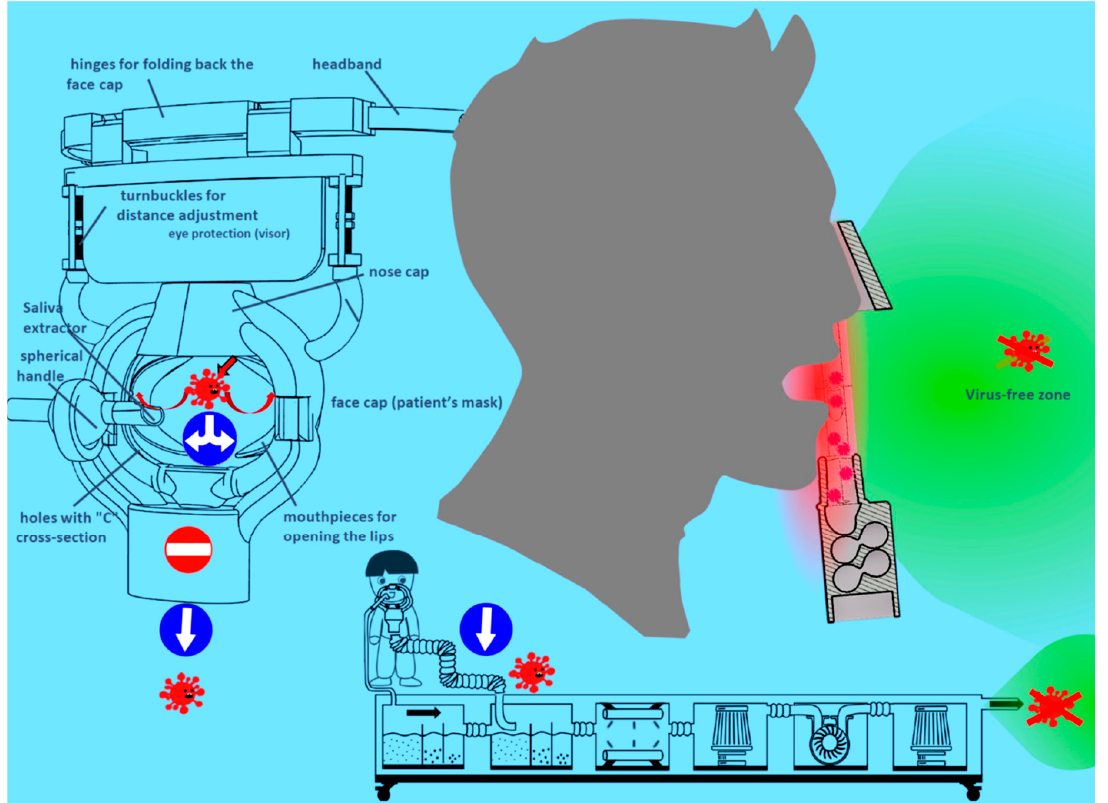
Figure 36. Diagram of one of the face cap solutions and an example of its use with a set of devices shown in the lower part of the drawing.